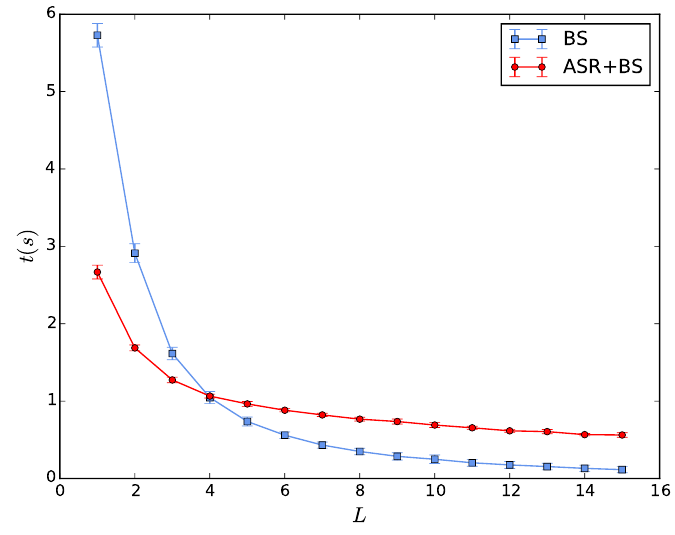
Figure 8. The computational time of the BS and ASR+BS algorithm versus the increasing side length of the